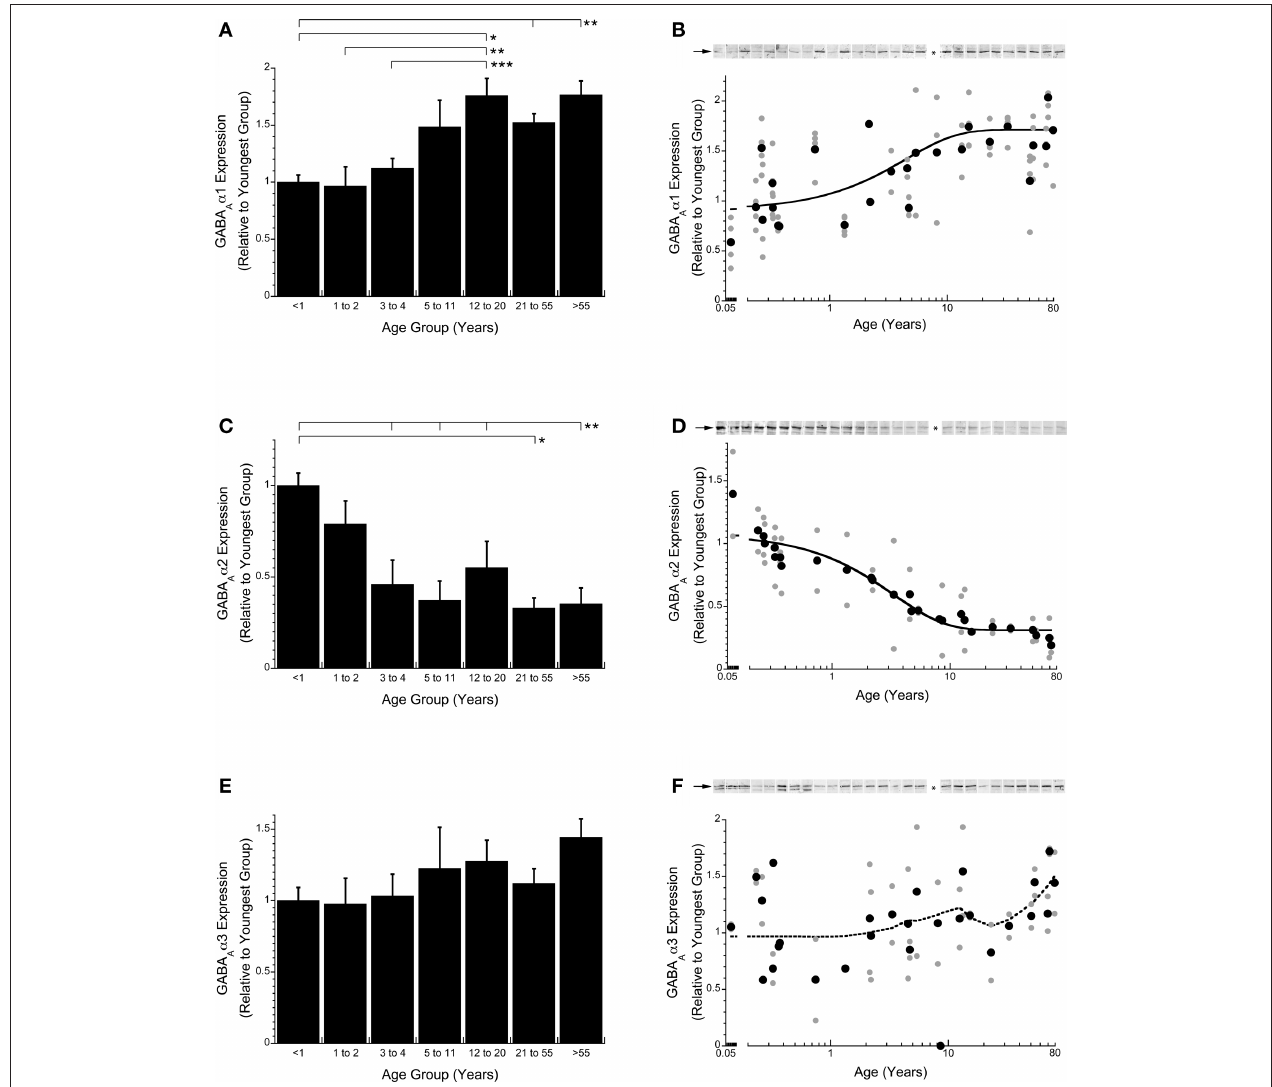
FiGure 4 | Changes in expression of GABA receptor subunits GABA expression decreased until older childhood when it leveled off (3 τ = 10 years of α 1 A A (A,B), GABA age, τ = 3.34 years, R = 0.96; p < 0.0001; D ). GABA α 2 (C,D), and GABA α 3 (e,F) during postnatal development. A A An exponential decay function (solid line) was fit to the expression levels for change significantly throughout the lifespan (e,F) (dotted line is the weighted GABA average). The lines above the histograms identify the groups that α 1 and GABA α 2 and the time constants ( τ ) were calculated with adult A A levels defined as 3 τ . GABA α 1 expression increased until early teens when it A leveled off (3 τ = 13.5 years, τ = 4.50 years, R = 0.67; p < 0.0001; B ). GABA α 2 A